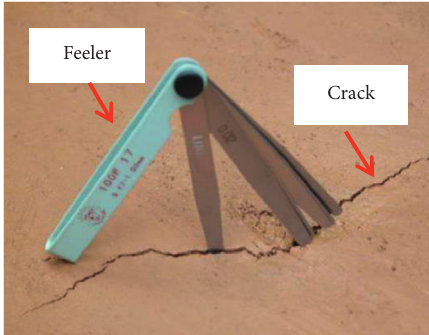
Figure 4: Measuring the crack width.